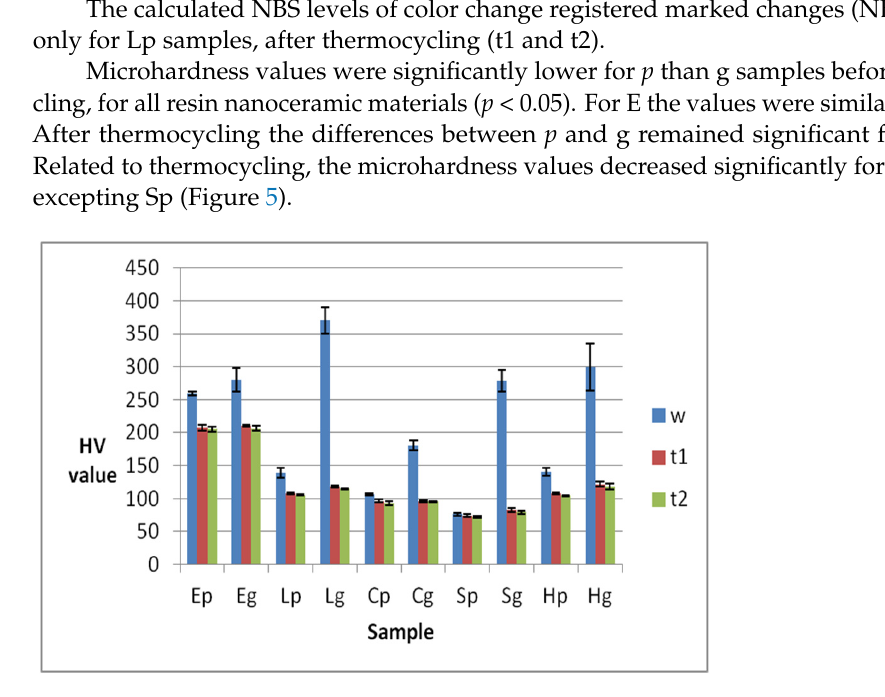
Figure 5. Mean microhardness values and SD of the samples, before and after thermocycling. Related to materials, for p samples before thermocycling, the values decreased sig- nificantly as follows: Ep>Hp>Lp>Cp>Sp, except from Hp to Lp. For g samples they de- creased as follows: Lg>Hg>Eg>Sg>Cg, being significant only between Sg and Cg. After thermocycling, values decreased as follows: Ep>Lp>Hp>Cp>Sp, being insig- nificant between Lp and Hp, and Cp and Sp. For glazed samples they decreased as fol- lows: Eg>Hg>Lg>Cg>Sg, being insignificant between Hg and Lg. 4. Discussion Based on the results of this in vitro study the null hypothesis was confirmed, namely that all of the materials included in this study were influenced by the hydrothermal ag- ing. Based on the results, thermocycling significantly decreased the Vickers hardness. Thermocycling may cause water absorption in the resin material structure. A conse- quence is an expansion of the network and decreasing of the frictional forces between polymer chains. Studies made suppositions that the assimilated water would lead to hydrolysis of the silane coupling agent, altering the chemical bond between the fillers and the resin matrix [62,63]. Other studies speculated that differences in the thermal ex- pansion coefficients of the two phases could induce stress at the network interfaces. Ex- periments demonstrated that an equilibrium should be reached after 30 days and further storage in water did not alter more the mechanical properties [64]. The hardness of polished samples decreased with the decrease of the inorganic filler content, both before and after thermocycling, and for glazed samples after thermocy- cling, because the glaze was not kept on the surface. Glaze temporary increased the mi- crohardness, but was removed by thermocycling. This means that aging due to thermo- cycling affecting the materials differently in relation to surface processing and glazing should be avoided. Other studies showed that different materials behave differently under thermocycling [64]. Related to the studied materials, PICN ceramic (E) was ob- tained through infiltration of presintered ceramic with resin, inducing a higher density. This could be another reason that supports the higher microhardness of this material. On the other hand, resin nanoceramic materials contain hydrophobic elements such asure- thane dimethacrylate (UDMA), or hydrophilic elements such as triethylene glycol di- methacrylate (TEGDMA), and bisphenol A-glycidyl methacrylate (Bis-GMA), which can explain the decreased microhardness caused by an increase of the susceptibility to wa- ter sorption [65,66]. Ethoxylatedbisphenol A diglycidyl methacrylate (Bis-EMA) is a type of ethoxylatedBis-GMA that is highly hydrophilic and has no reactive hydroxyl group in its main polymer chains. It should therefore exhibit insignificant water sorption. Studies investigated composites with different filler particles and showed that those with larger fillers are more susceptible to color changes related to water sorption than those with